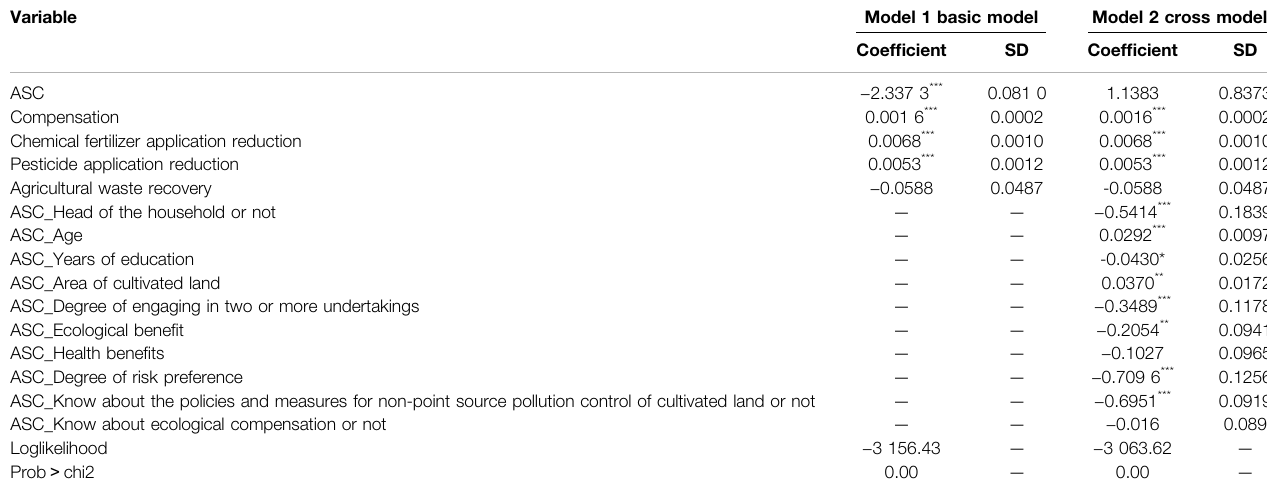
TABLE 4 | Empirical results of MNL model. Variable